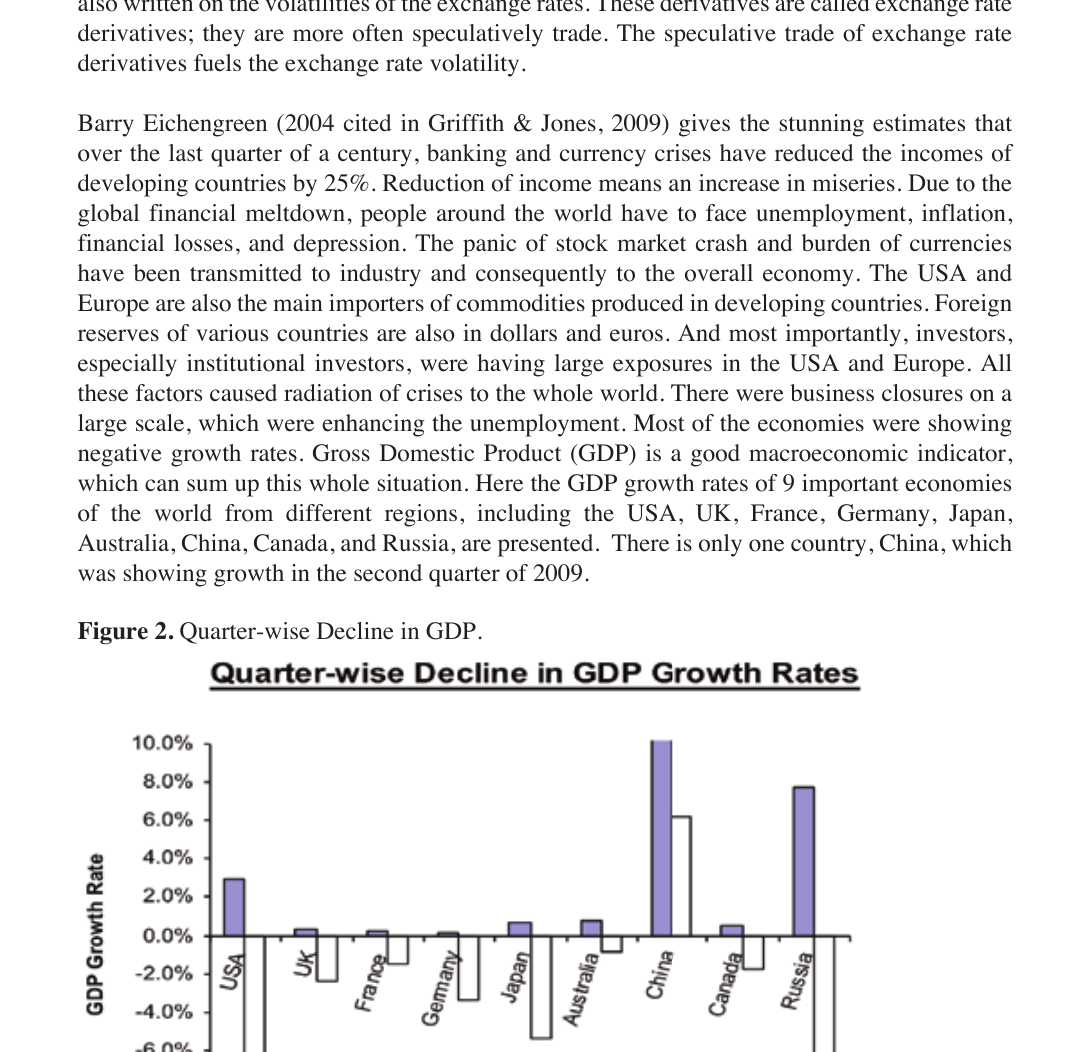
Growth Rates of selected countries. Data retrieved from www.tradingeconomics.com on 2nd Nov.